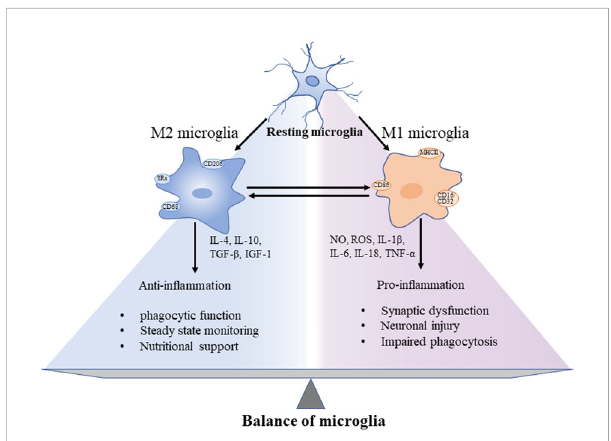
FIGURE 1 Different functions of microglia showing the “ two-sided ” characteristics of microglia and the balance between pro- and anti-in fl ammation in the progression of CNS neuroin fl ammation. These microglial phenotypes display different cell surface receptors and secreted factors, among which, by secreting anti-in fl ammatory cytokines and trophic factors to promote phagocytosis, maintain homeostasis, and nourish nerves. In addition, the surface tightening was activated to cause both synaptic dysfunction and neuronal